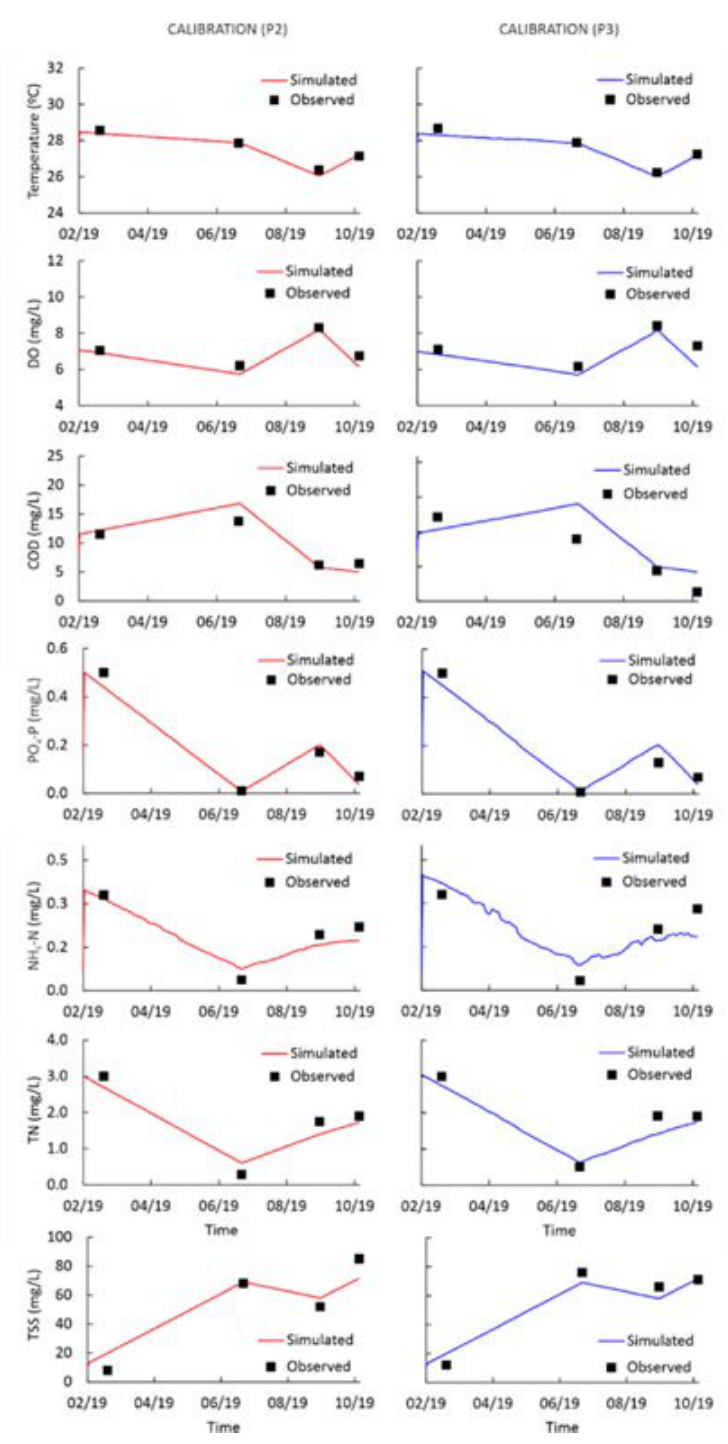
Fig. 5: Calibration and validation of physicochemical parameters at point 2 (red) and point 3 (blue)